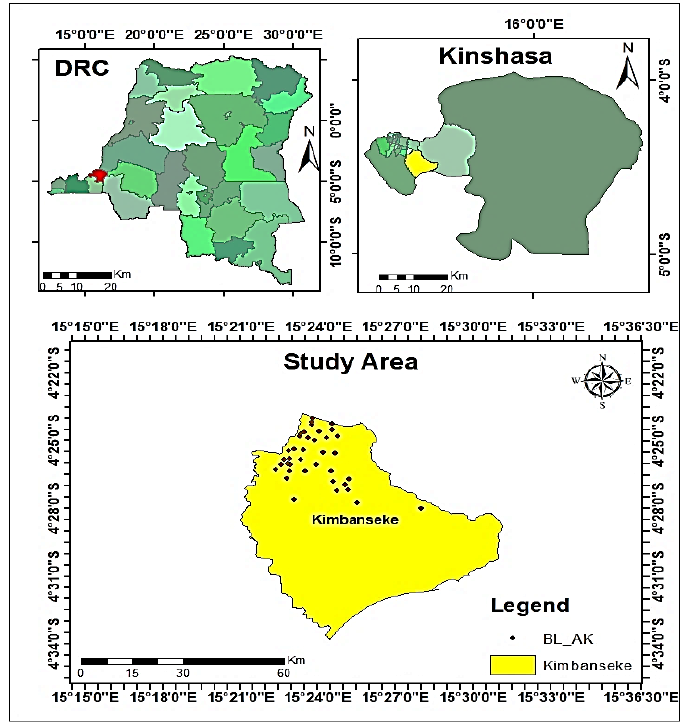
Figure 4. The Study area of Kimbanseke.